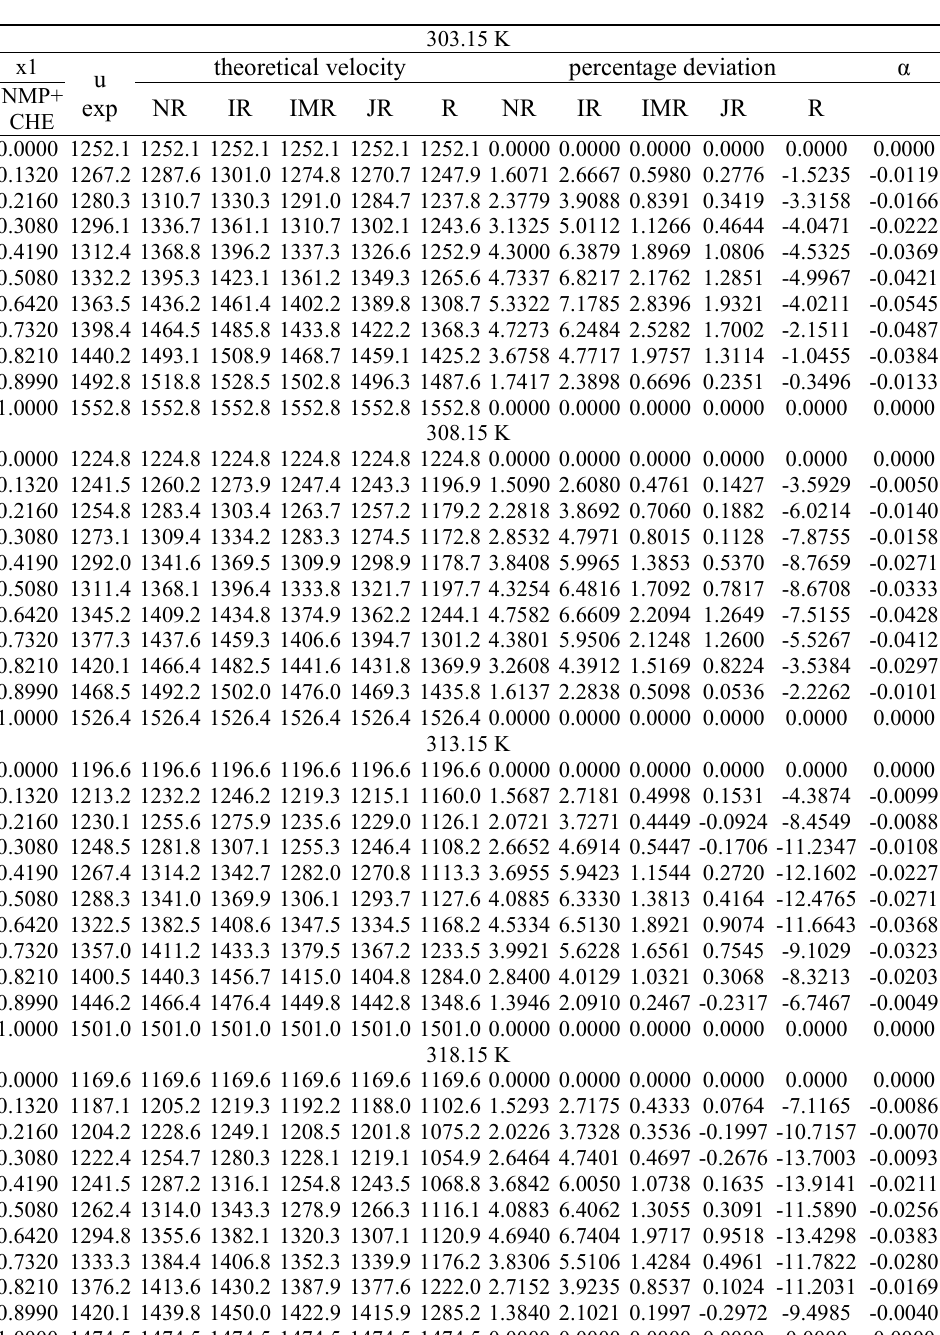
Table 3. The experimental velocity(U), the theoretical velocity, percentage deviation and molecular interaction parameter (α) for the system N-Methyl-2-pyrrolidone with cyclohexene at different